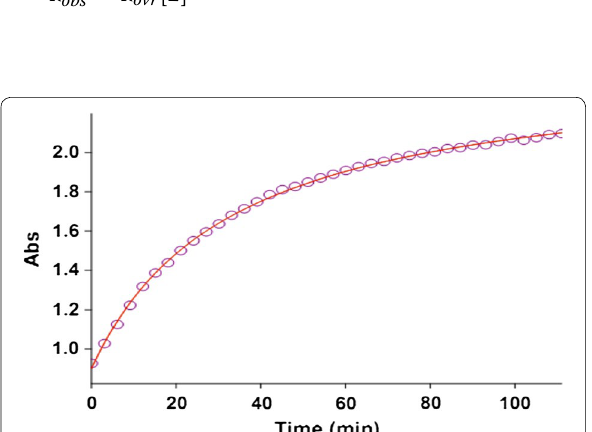
Fig. 4 The original experimental absorbance curve versus time at a selected wavelength of 305 nm for the reaction between ( 1 ) (10 − 2 M), ( 2 ) (5 10 − 3 M catalyst) and ( N – H ) (10 − 2 M) in methanol. The dotted × curve shows experimental values, and the solid line is the fitted curve